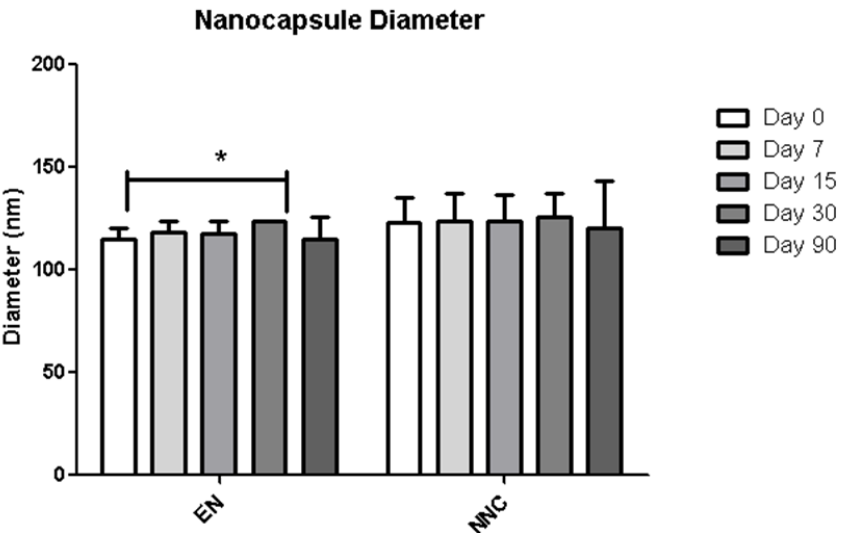
Figure 4. Distribution of diameter of empty nanocapsules (EN) or nicotine containing nanocapsules (NNC) for a period of 90 days of storage. Just a slight difference in size was observed between day 0 and day 90 in the empty nanocapsules, while the others remained stable throughout the period of analysis. p < 0.05-day 0 vs. day 60 ( n = 3). *: p < 0.05.